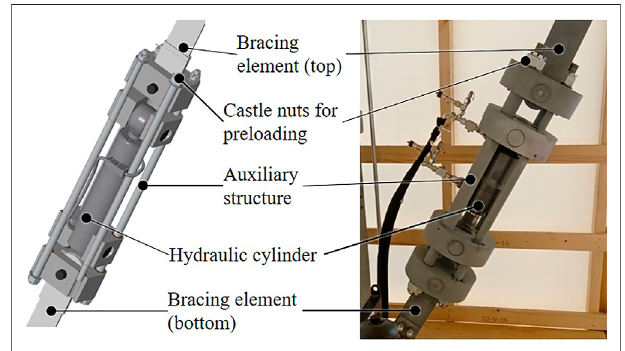
FIGURE 7 | Visualization (left) and realization (right) of the bracing- actuator assembly (Source: